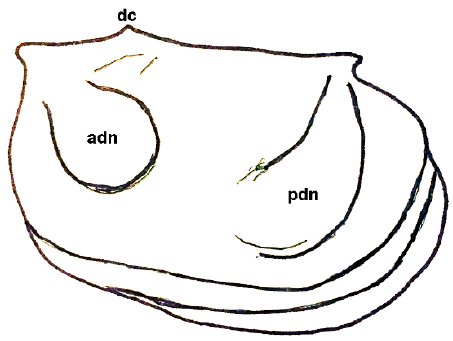
Figure 11. Cambria sibirica . Anterior to left. Length of shield 3 mm. Abbreviations: adn , anterodorsal node; dc , dorsal cusp; pdn , posterodorsal node. Image Credit: Mark McMenamin.